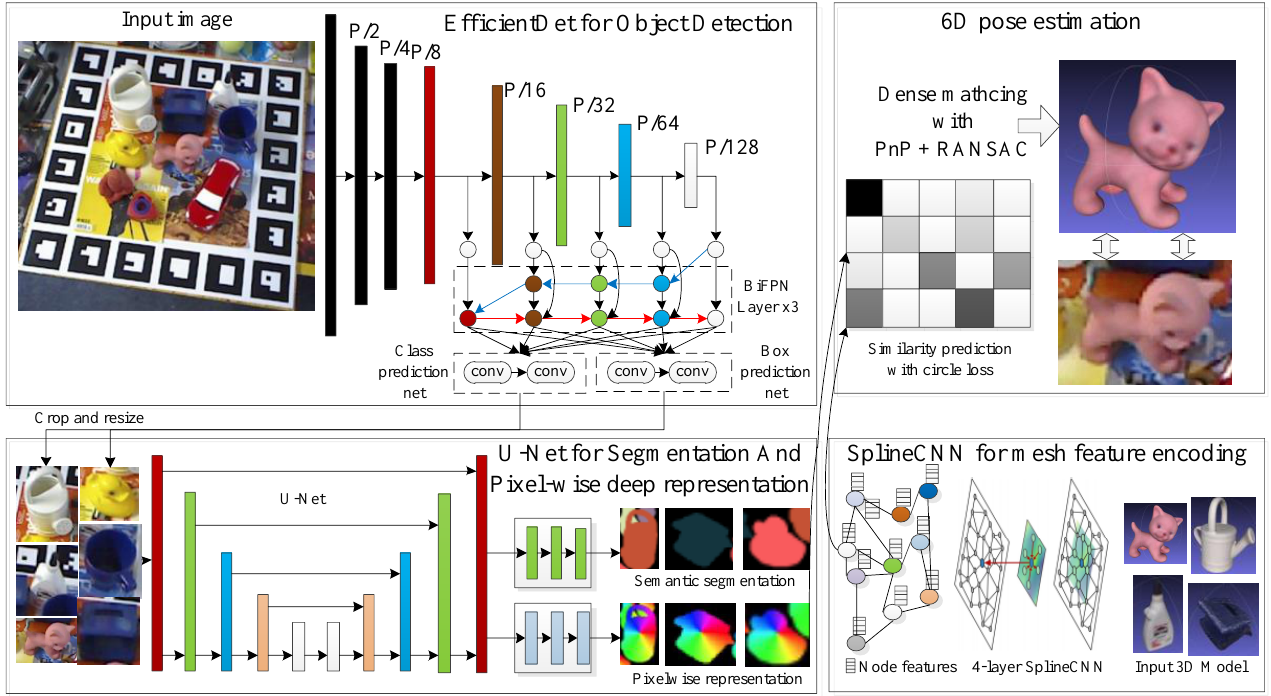
Figure 1. Flowchart of our proposed two-stage pose estimation